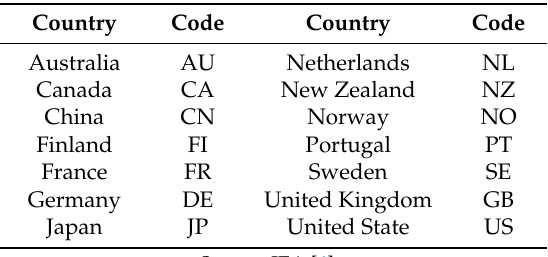
Table 1. List of countries in electric car industry.